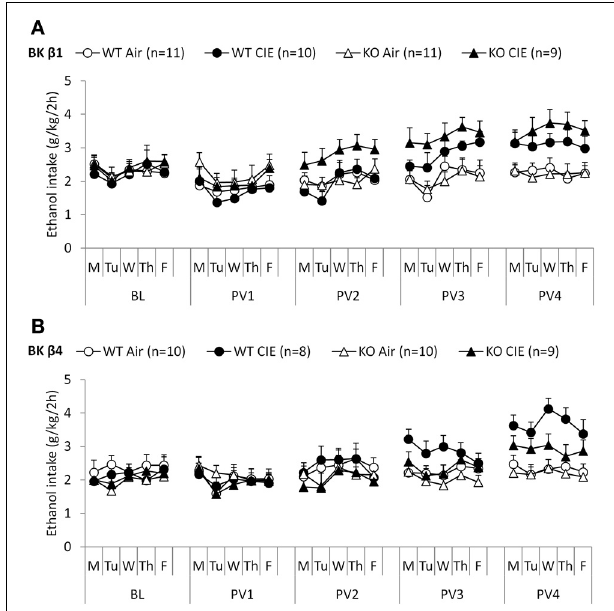
FIGURE 2 | Experiment 2: Ethanol intake under limited access and following dependence induction. Individually-housed BK β 1 (A) and BK β 4 (B) WT and KO mice were first offered access to ethanol (15% v:v) and water in their home cages for 2h per day on weekdays (baseline, BL). Weeks of chronic intermittent ethanol (CIE) or air inhalation were then alternated with weeks of post-vapor (PVn) voluntary ethanol drinking. Number of mice in each group is indicated in the legend.